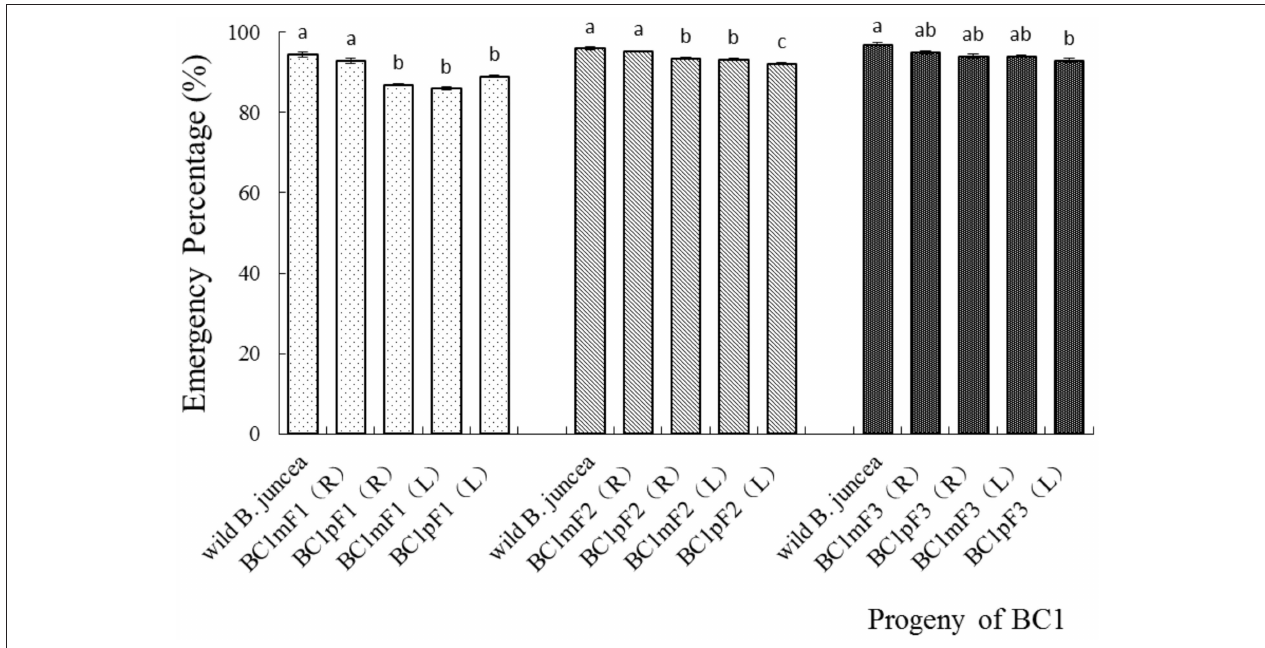
FIGURE 2 | Emergence percentages of the first- to the third-generation progenies of BC1. Data are shown as the mean ± SE ( n = 10). Different letters in the different progenies of the same generation indicate significant differences using Duncan’s multiple range test, P < 0.05. BC1mF1(R) to BC1mF4(R) and BC1pF1(R) to BC1pF4(R) are the first- to fourth-generation progenies of the first backcross generation (BC1) obtained from wild Brassica juncea × F1R or F1R × wild B. juncea , respectively. BC1mF1(L) to BC1mF4(L) and BC1pF1(L) to BC1pF4(L) are the first- to fourth-generation progenies of the first backcross generation (BC1) obtained from wild Brassica juncea × F1L or F1L × wild B. juncea , respectively. F1R and F1L indicate the glyphosate- or glufosinate-tolerant F1 hybrids from wild B. juncea × glyphosate- or glufosinate-tolerant transgenic oilseed rape. Progenitors in front of the × are always the maternal plants, and the progenitors after the × are always the paternal